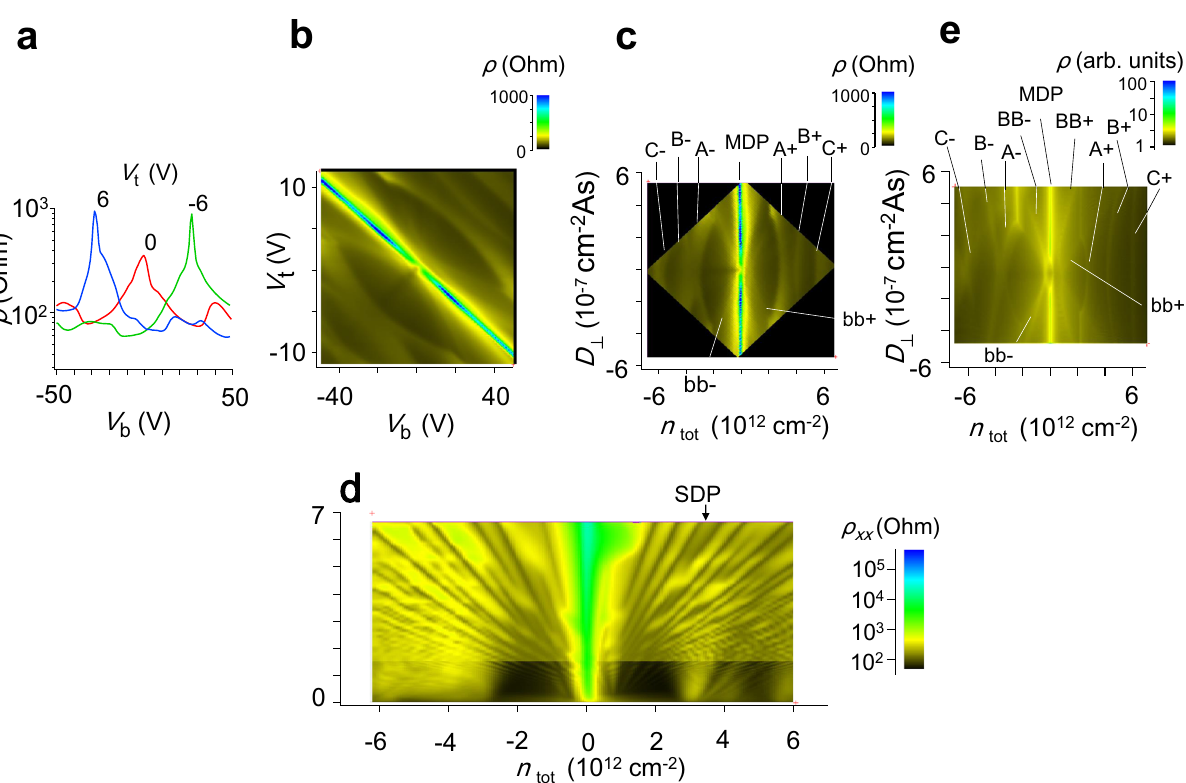
Fig. 2 Resistance peaks due to moiré superlattice. a V b -dependence of ρ for different V t . ( T = 4.2 K). b Map of ρ plotted as a function of V b and V t ( T = 4.2 K). c Map of ρ plotted as a function of carrier density ( n tot ) and perpendicular electric fl ux density ( D ? ). Some of the salient ridges are labeled as A + , A − , B + , B − , C + , C − , bb + , bb-, and MDP. T ¼ 4 : 2 K and B ¼ 0 T. d Map of longitudinal resistivity ρ xx ð B Þ vs. n tot . T ¼ 4 : 2 K. Perpendicular electric fl ux density ( D ? ) was kept at zero by tuning V b and V t . The arrow indicates Landau levels that are reminiscent of those of the secondary Dirac cone in the moiré superlattice of the h -BN/ single layer graphene heterostructures. e Map of ρ numerically calculated by using the effective mass approximation with the SWMcC parameters of graphite. The effective moiré potential derived by Moon and Koshino 24 was used with a mismatch angle of 0.35°. The amplitude of the moiré potential was scaled with a factor of 0.5. Labels correspond to those in panel c . Ridges BB + and BB − , which are not clearly visible in c , arose from the bottom of the heavy-mass bilayer-like